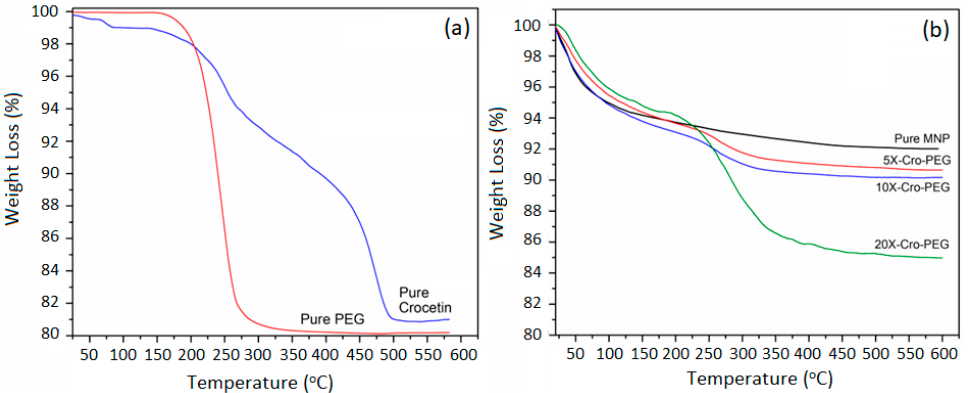
Figure 6. ( a ) TGA thermograms of the crocetin-functionalized pegylated MNPs as a function of the concentration of crocetin, ( b ) TGA thermograms of pure PEG and crocetin. The possible binding mechanism of crocetin to PEG is illustrated in Scheme 2. Cro-